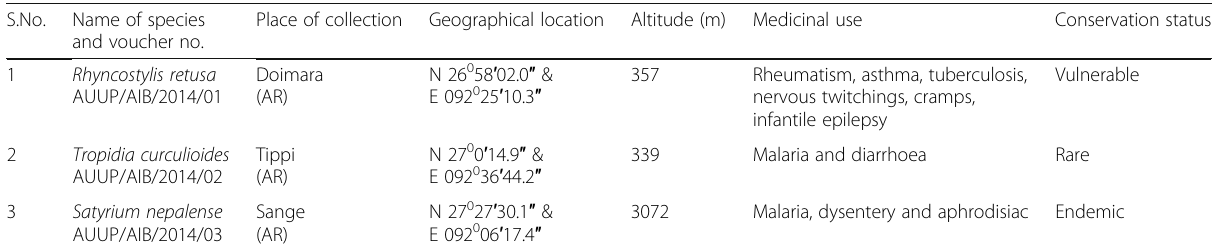
Table 1 Orchid species collected from Arunachal pradesh (AR); their geographical location, medicinal use and conservation status